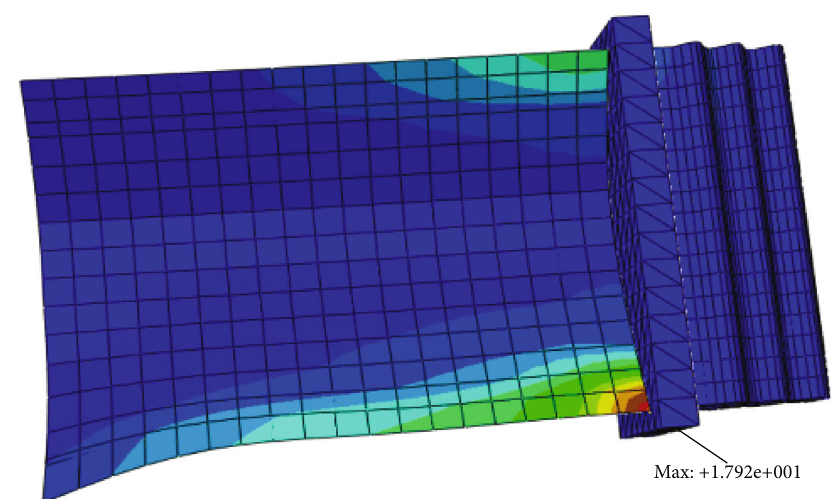
Figure 6: RMS stress cloud